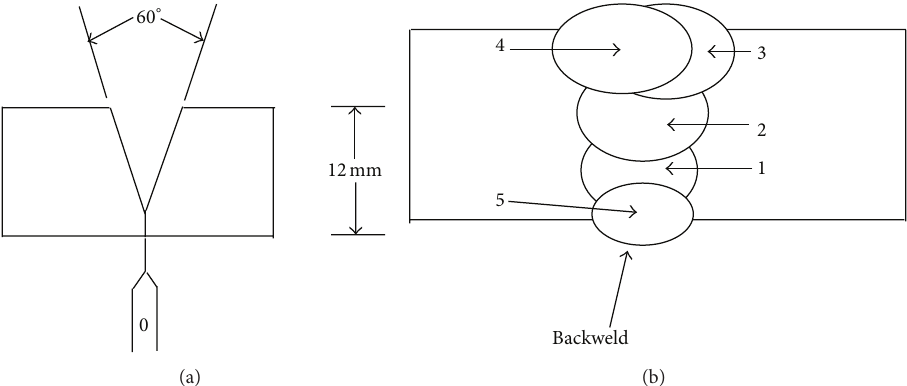
Figure 1: Welding details of AA6061 Al alloy plates: (a) joint configuration and (b) welding sequence, 1 → 2 → 3 → 4 → 5 (backweld).